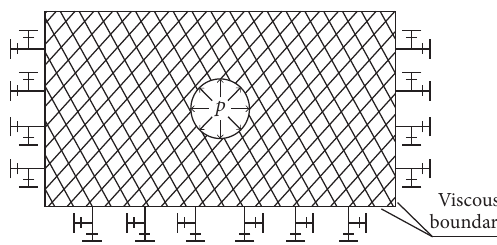
Figure 6: DDA model under blasting loading.